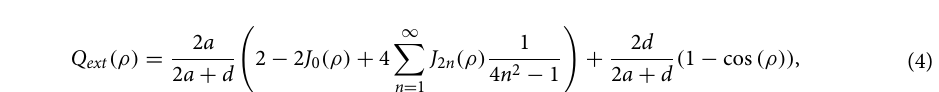
Figure 3. In frame ( a ), the exact extinction efficiency is shown for a cylinder in the case where the E -field is parallel to the cylinder axis (blue line). The radius of the cylinder is 10 µ m and the refractive index is 1.3. The red dashed line shows the approximation of Q ext given in Eq. (3). The yellow line is the extinction efficiency the stadium shaped scatterer will approach according to Eq. (4) when d >> a in the case where the thickness of the straight part is 20 µ m and the refractive index of the scatterer is 1.3. Frame ( b ) shows Q ext of a stadium with a refractive index of 1.3 and a radius of the circular end caps equal to 10 µ m . The length of the straight sections is 0 µ m (blue lines), 5 µ m (red lines), 10 µ m (yellow lines) and 15 µ m (purple lines). The figure shows that the wiggles are shifted to the right both according to the COMSOL Multiphysics simulations of the electromagnetic field (solid thick lines) and according to the approximation of Q ext (thin lines with circles) given by Eq. (4). For the frames ( c )–( f ), the radius of the circular end caps is 10 µ m and the refractive index of the scatterer is 1.3. Frames ( c )–( f ) show the norm of the E-field in the case where a plane wave is incident from the left 1 with wavenumber ˜ ν = 2600 cm − . Frame ( g ) shows Q ext as a function of wavenumber. The change in Q ext is illustrated as a function of the length d of the straight sections of the stadium as we change d from 0.001 (dark blue), which is close to a disk, to a stadium with d = 50 µ m (dark red). The radius of each of the endcaps is 10 µ m and the refractive index of the stadium is 1.8. The simulations are done by COMSOL